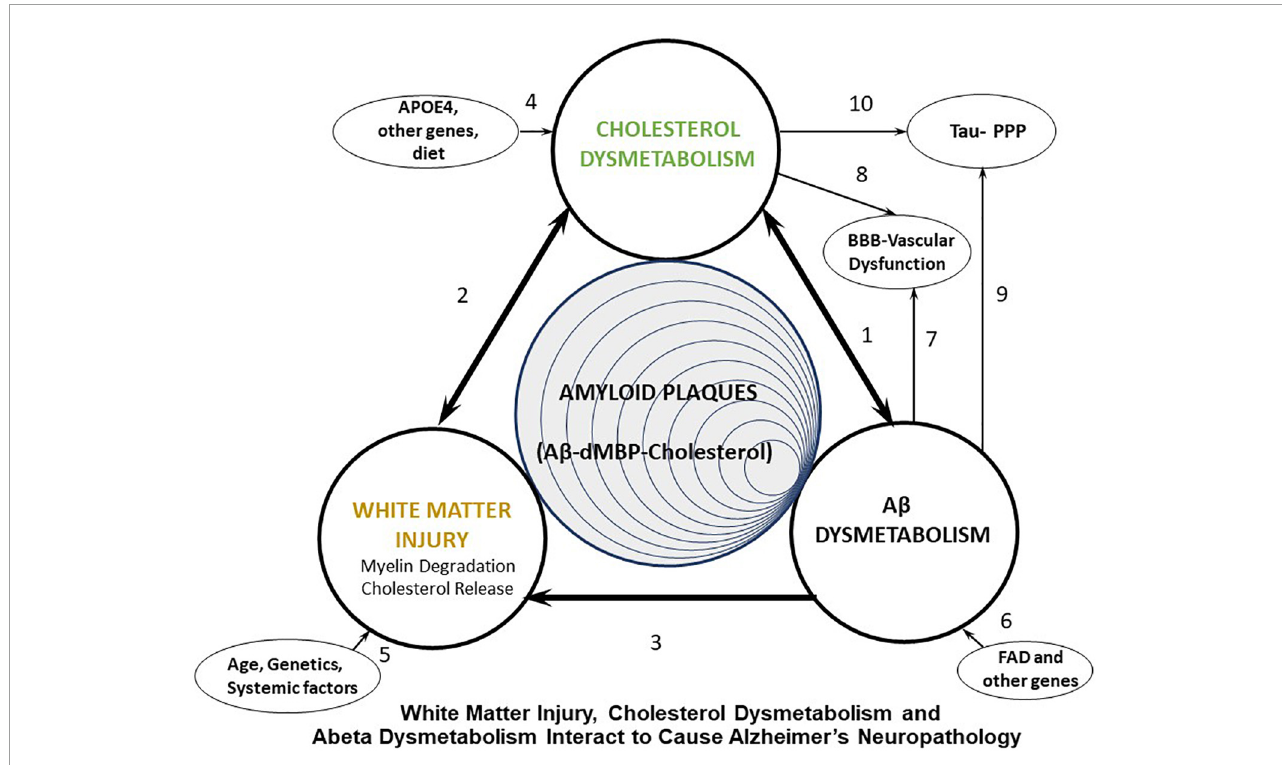
FIGURE1 Diagram showing proposed interactions between white matter injury, cholesterol dysmetabolism, and Abeta dysmetabolism that leads to Alzheimer’s plaques, Tau hyperphosphorylation (Tau-PPP), and vascular dysfunction in Alzheimer’s disease (AD). FAD, Familial Alzheimer’s disease (early onset AD); dMBP, degraded myelin basic